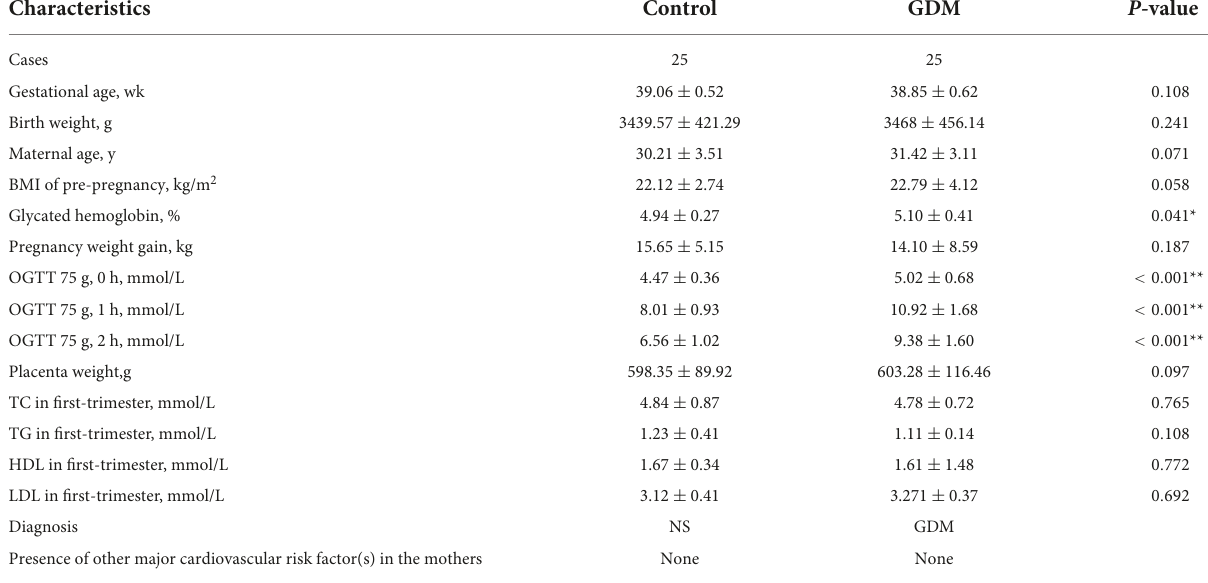
TABLE 1 Clinical characteristic of the